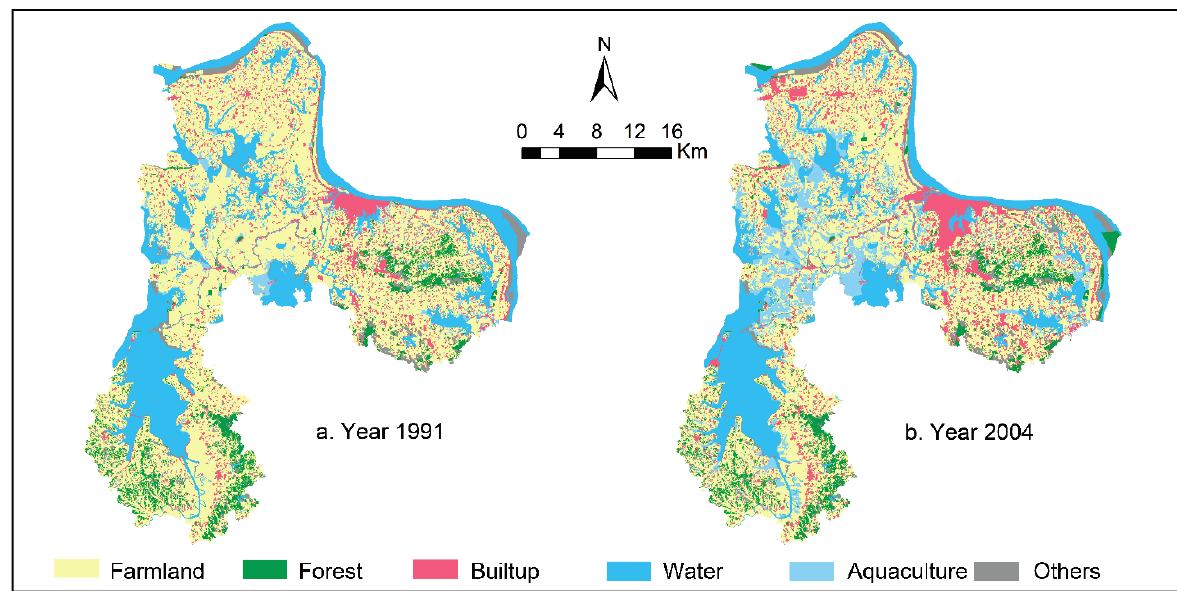
Figure 1. Map of the study area: Ezhou City, China.